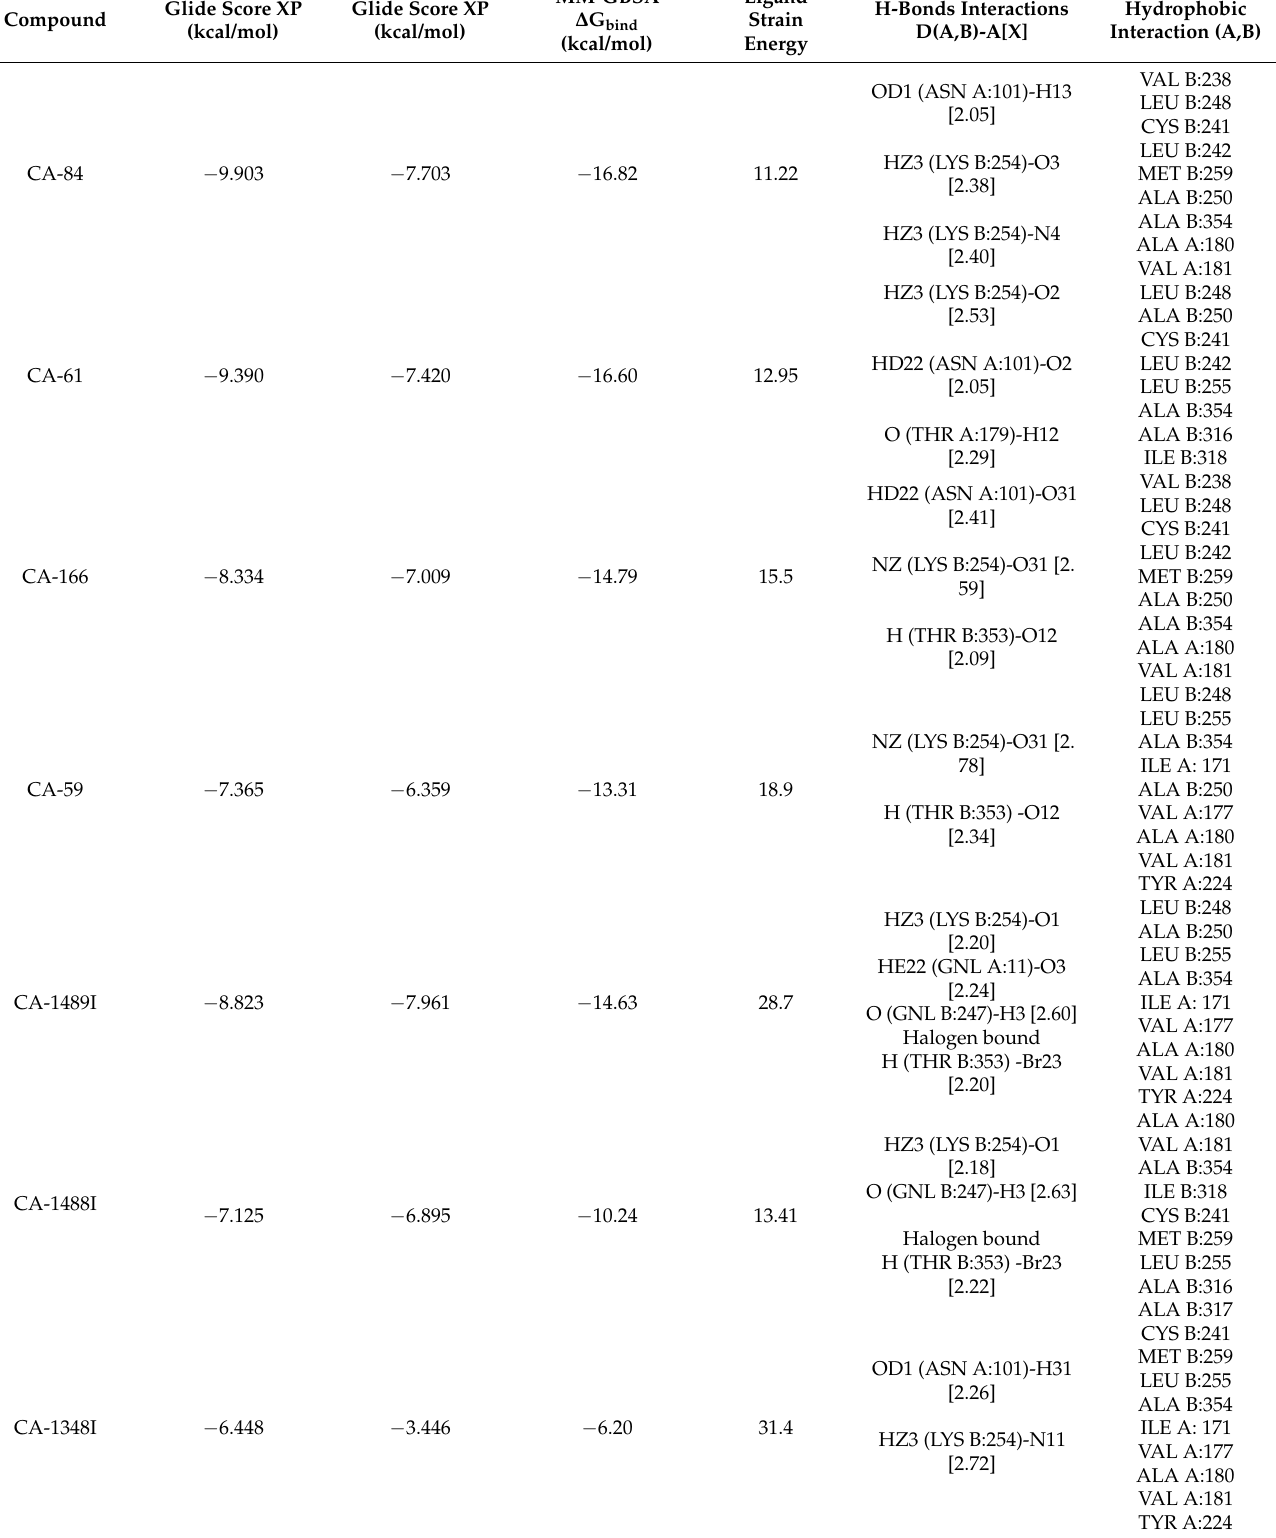
Table 1. Docking score (SP and XP Modes), MM-GBSA ∆ Gbind prime energy, ligand strain energy, H–bond, and hydropho- bic interactions of the top-ranking